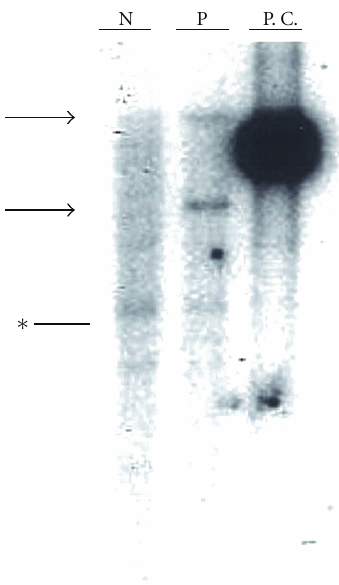
Figure 1: Infection status of EBV was monoclonal. DNA from the patient’s peripheral blood mononuclear cells was digested by EcoRI, and southern blot hybridization was performed with EBV BamHI W probe. An arrow points at the monoclonal bands. Asterisk shows the non- specific band. N: normal control; P: patient; P.C.: positive control (Raji cells).